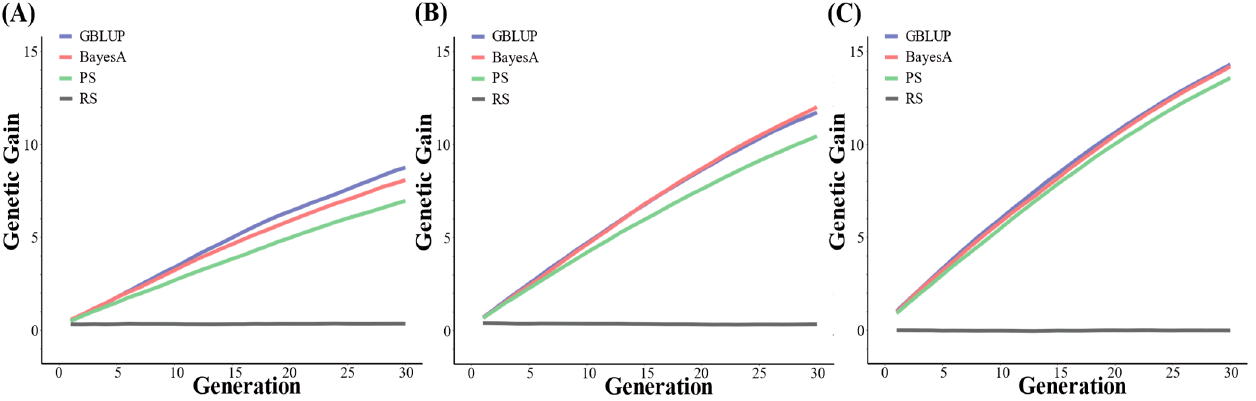
Figure 3. Genetic gains across 30 generations using 4 strategies with low, medium, and high herita- bility traits based on 100 K SNPs. ( A ) Genetic gains for trait heritability of 0.1. ( B ) Genetic gains for trait heritability of 0.3. ( C ) Genetic gains for trait heritability of 0.5. In addition, the genetic gain rate of the 2nd generation ranged from 50.47% to 71.74%, while it decreased to around 2% in the 30th generation (Figure 4A).